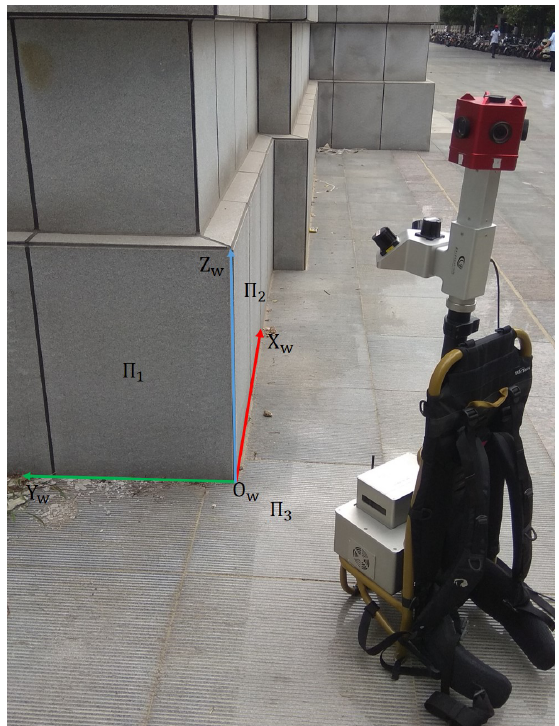
Figure 9. Real data experiment at the outdoor scene. Two planes of the building and the ground together constitute the trihedron described in Section 2.1. The three planes are denoted as Π 1 , Π 2 , and Π 3 , and the world coordinate system O W − X W Y W Z W is established by taking three edges of the trihedron as X , Y , and Z axis and the vertex of the trihedron as the